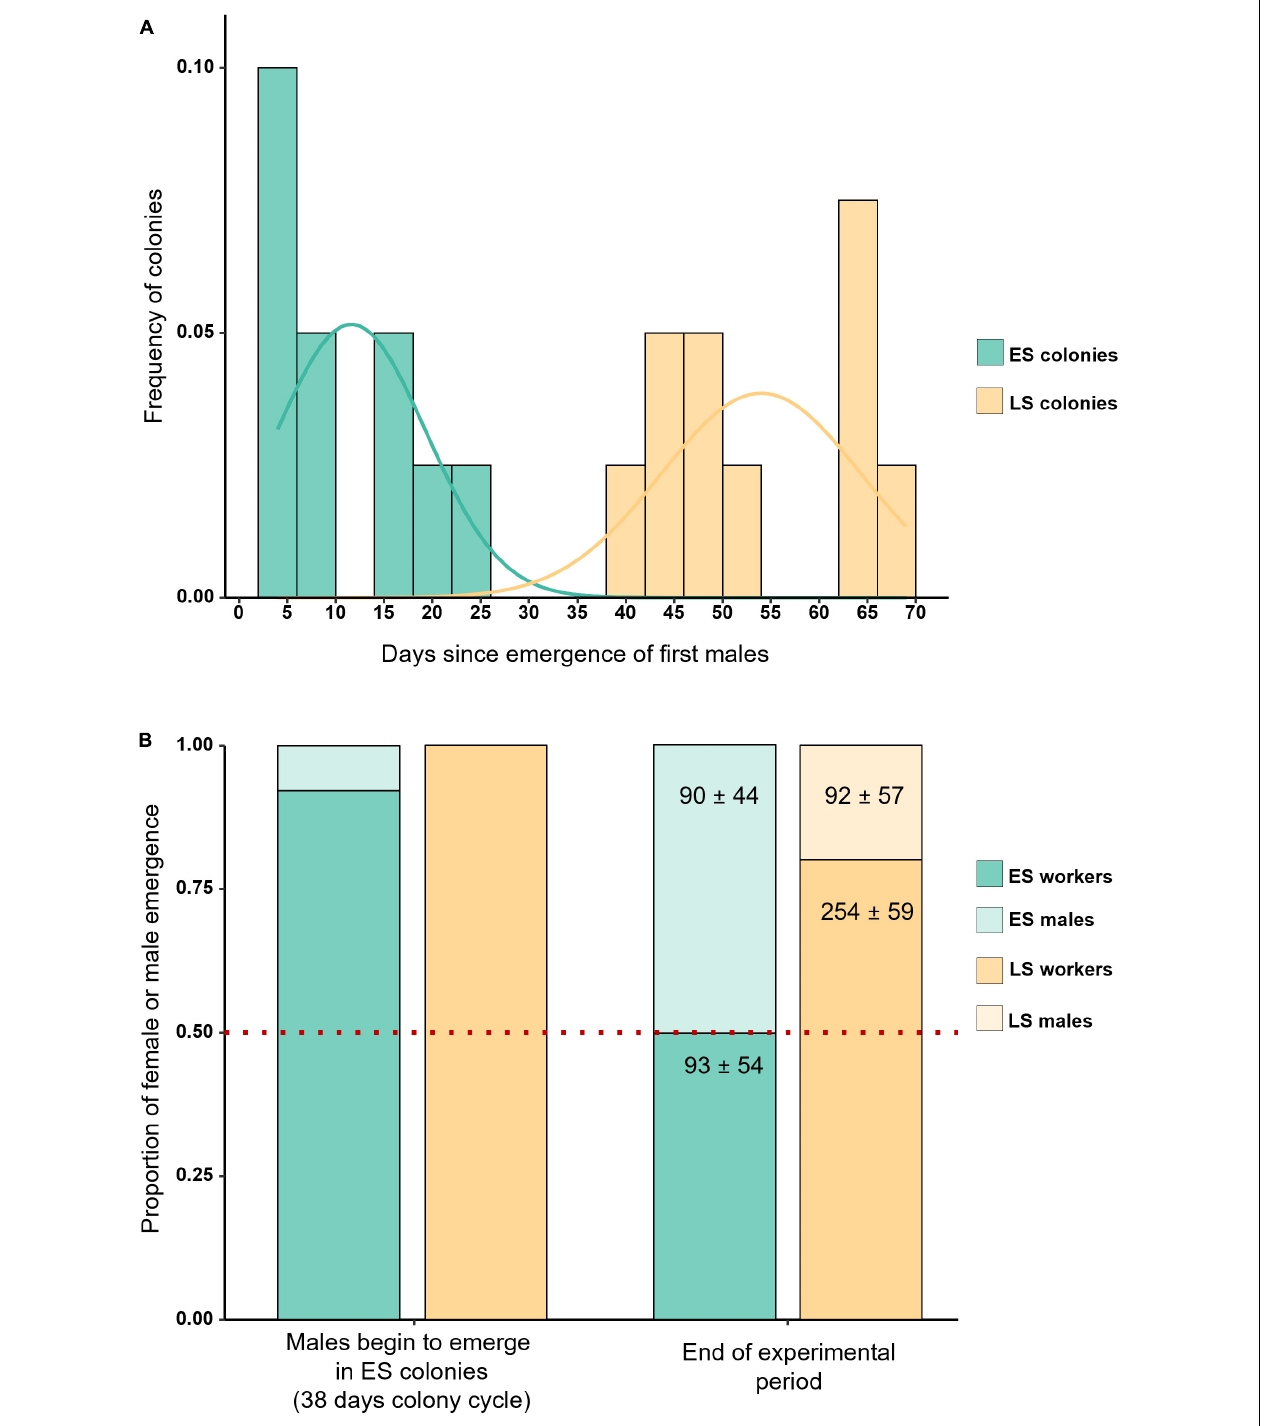
FIGURE 1 | The two colony types present distinct life-history traits. Density plot showing the bimodal distribution of the two colony types according to the date of emergence of the males. Males begin to emerge much earlier after the first worker cohort in early switching (ES) as opposed to late switching colonies (LS) as shown in the density histogram fitted with normal distribution per phenotype (A) . Effect plot of the proportion of female or male emergence ( y -axis) in two different moments of the observation: when the first males started to emerge in early switching colonies, and at the end of the experimental period when the colonies were frozen ( x -axis). The proportion of males being produced by each phenotype varies throughout the cycle with early switching colonies shifting from producing almost exclusively workers earlier on to 50% males and workers at the end of the experiment. Late switching colonies specialize in the production of females (workers and virgin queens) and begin producing males only at the end of the cycle (B)